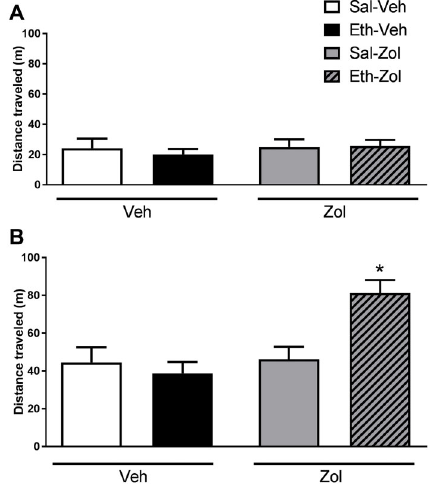
Figure 3. Locomotor activity quanti fi cation in the open- fi eld during the ( A ) saline (Sal) and ( B ) ethanol (Eth) challenges after ethanol and/or zolpidem treatments. Data are reported as means ± SE. *P o 0.05 compared to the respective control group (B: Sal-Zol)